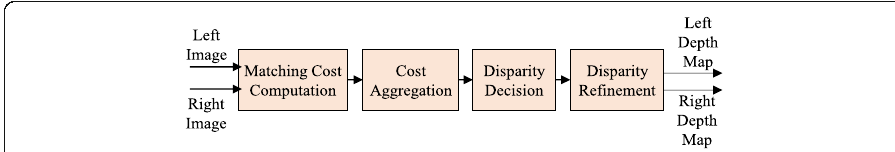
Fig. 1 Flow diagram of typical local stereo matching